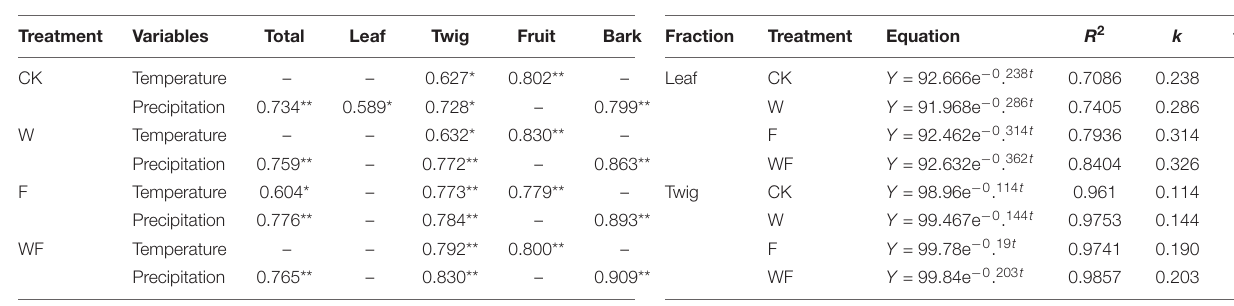
TABLE 2 | Analysis of the correlation between environmental factors and monthly litterfall productions from August 2019 to July 2020.